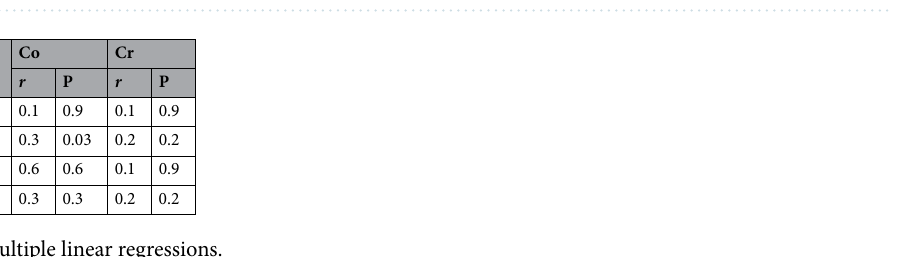
Figure 4. Forest plot of the comparison on Co.